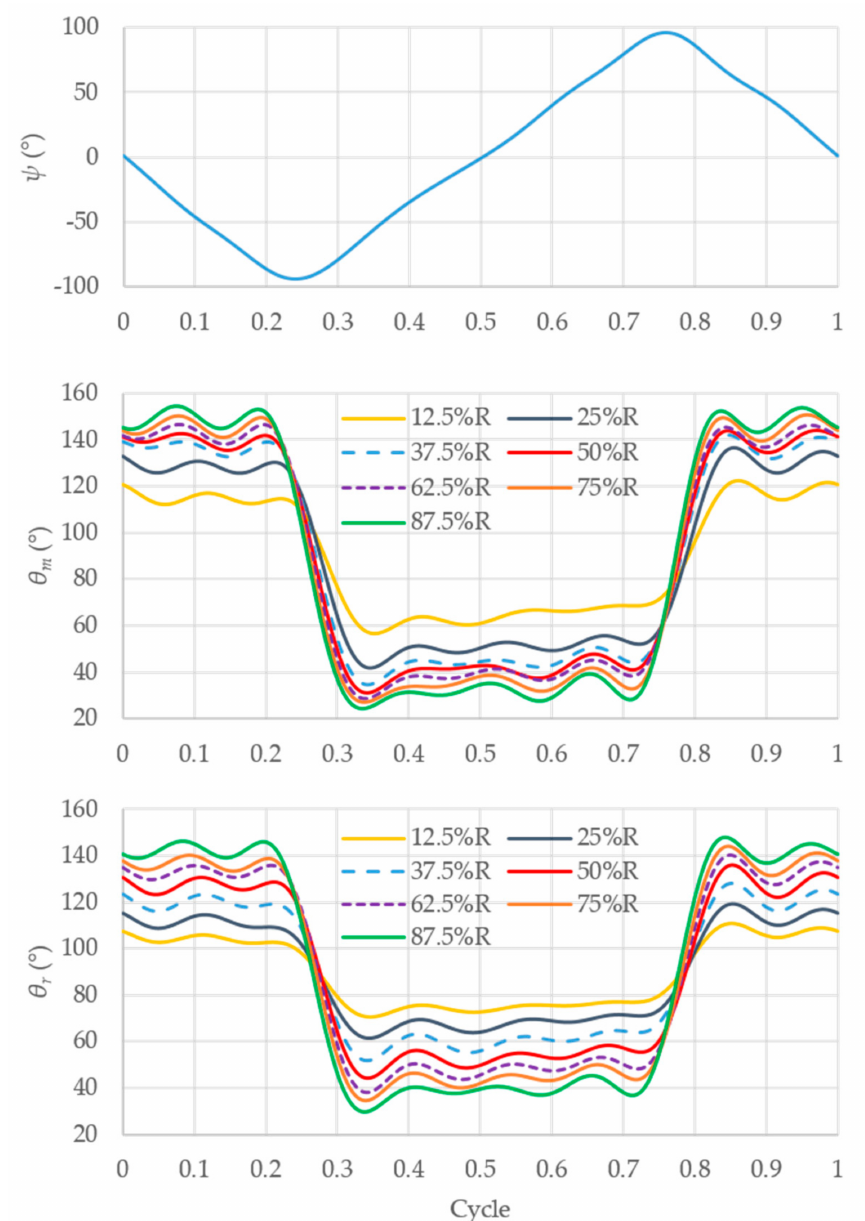
Figure 6. The time courses of wing